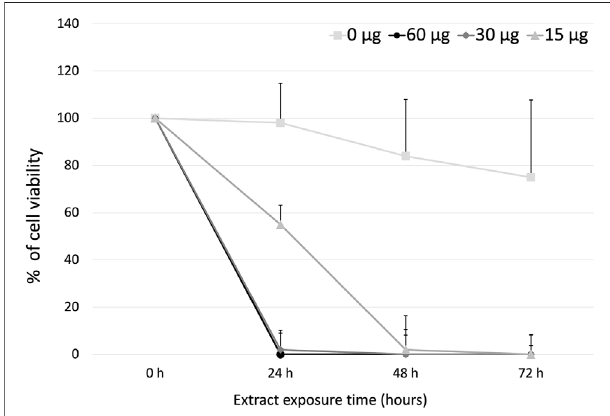
FIGURE3| Effectiveconcentration50 (µg/mL)ofthepolarfractionofthe ethanolic extract of Lophocereus schottii in murine lymphoma L5178Y cells. μ